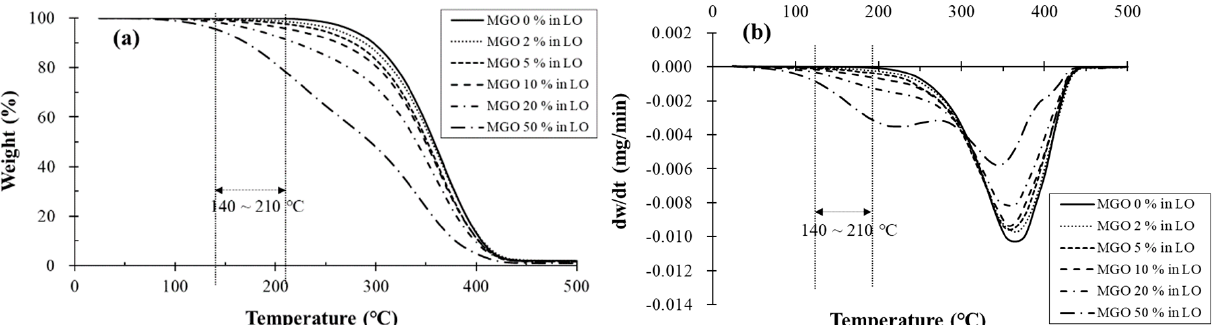
Figure 4. ( a ) Thermogravimetric analysis (TGA) and ( b ) derivative thermogravimetric (DTG) curves for standard samples (lubricating oil (LO) with 0, 2, 5, 10, 20, and 50% marine gas oil (MGO)).